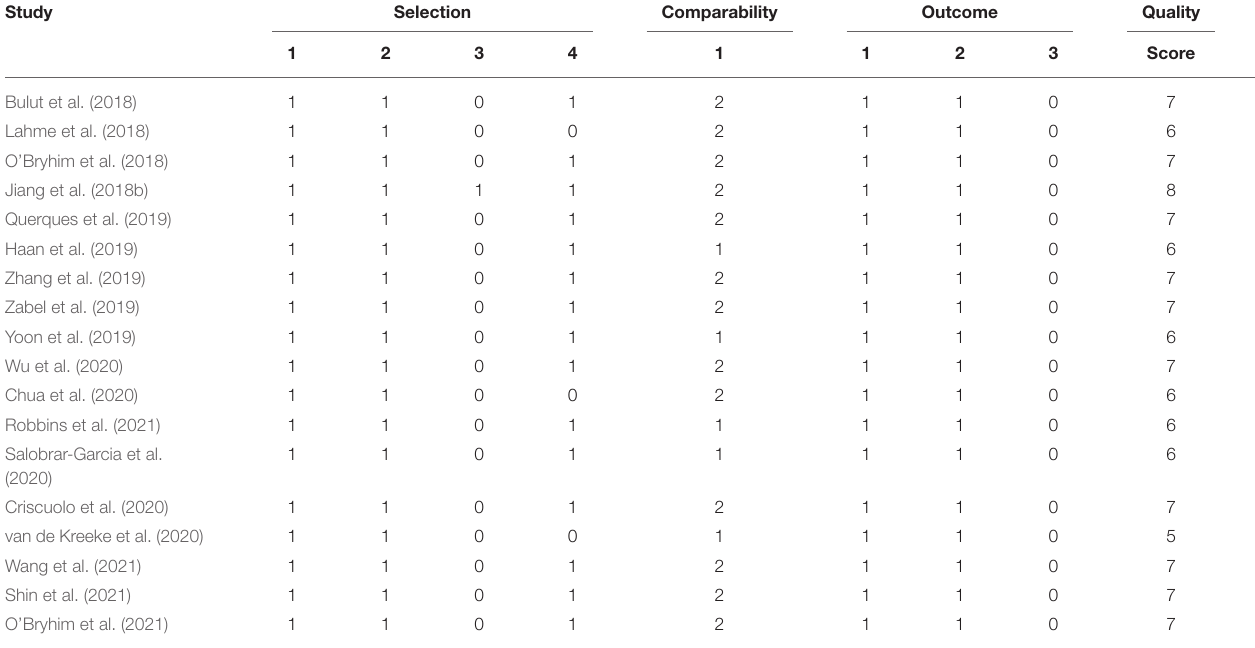
TABLE 1 | Newcastle-Ottawa Quality Assessment Scale of case control studies. Study Selection Comparability Outcome